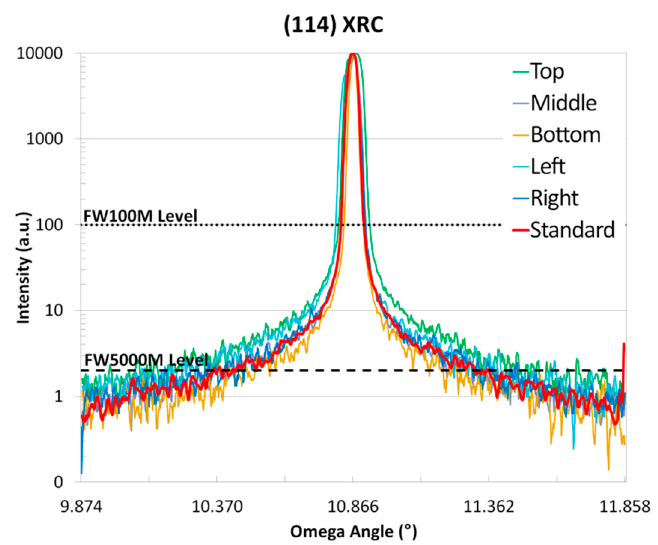
Figure 6. Omega 114 X-ray rocking curves measured at five locations on the G-polar side of a c -plane CMPed NEAT GaN wafer. A diffractogram of an as-grown NEAT GaN boule (shown in red) is used as a standard since its surface is free of any damage caused by surface processing. The width of the peaks at the 5000M level is used to quantify surface damage. The data has been smoothed with a smoothing ratio of 1 / 5 for easier visual comparison, and the intensity has been normalized to 10,000 counts, an arbitrary unit.